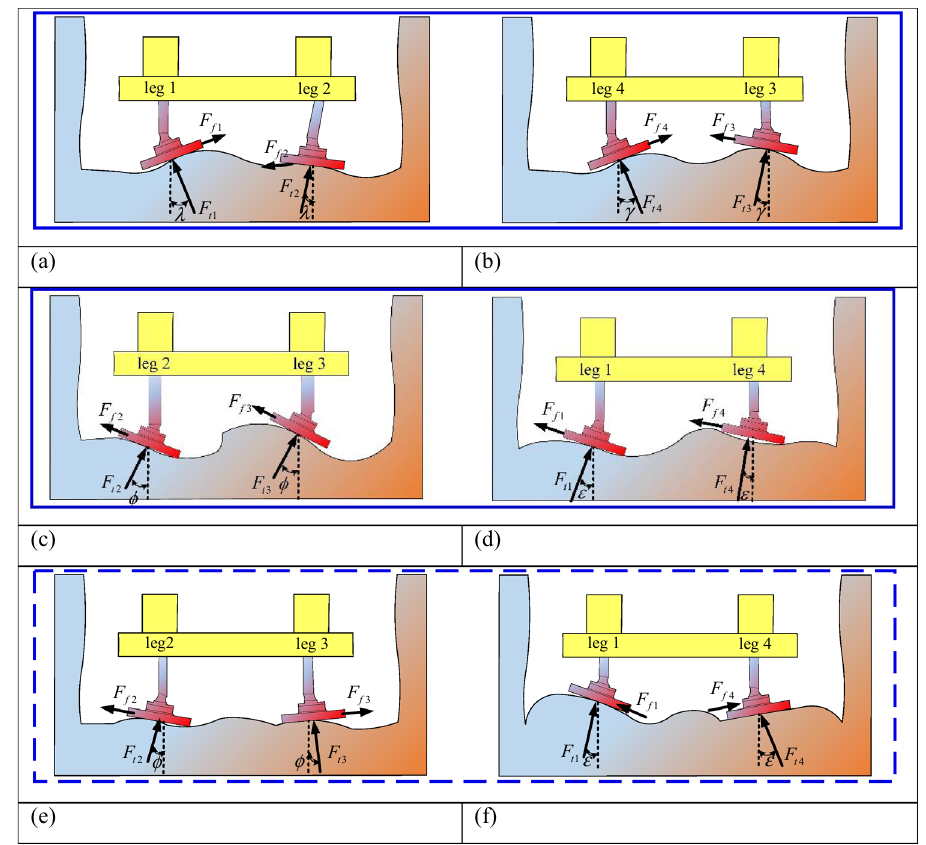
Figure 3. Angle between reaction force of supporting leg and coordinate axis: ( a ) angle between 1 and 2 leg and XZ cross section; ( b ) angle between 3 and 4 leg and XZ cross section; ( c ) angle between 2 and 3 leg and YZ cross section(outward legs); ( d ) angle between 1 and 4 leg and YZ cross section(outward legs); ( e ) angle between 2 and 3 leg and YZ cross section(inward legs); ( f ) angle between 1 and 4 leg and YZ cross section(inward legs).